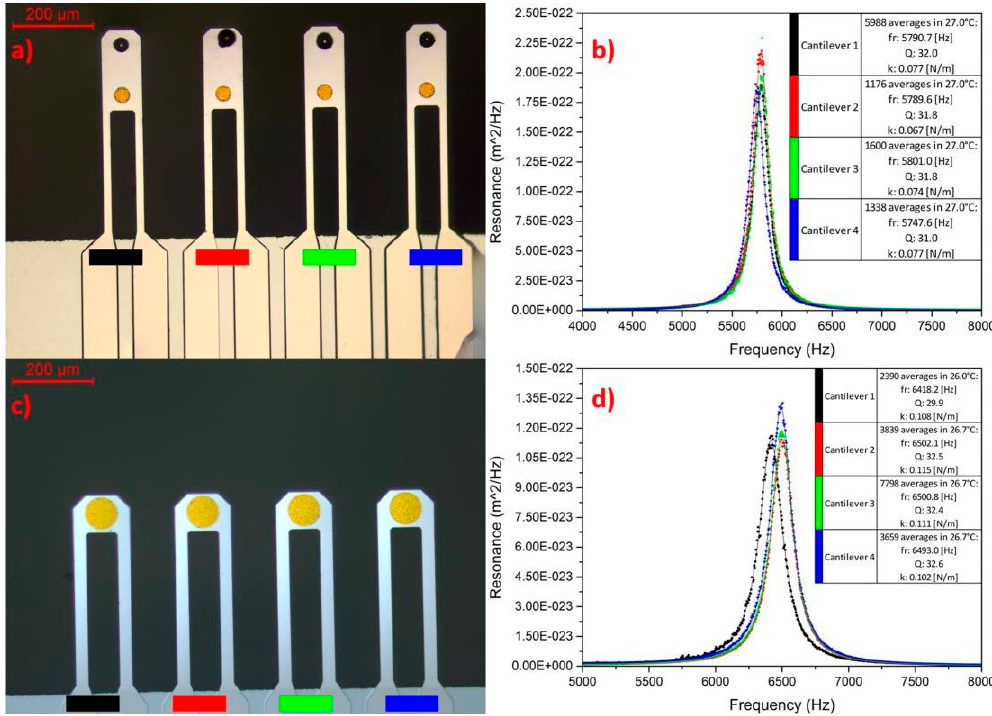
Figure 1. ( a ) Electromagnetically actuated array cantilevers with sphere mounted near their free end. Each cantilever integrates its own conductive loop, allowing for independent motion control; ( b ) thermomechanical noise measurements of the cantilevers (before sphere placement). The thermomechanical noise provides the estimated mechanical properties of each cantilever ( c ) Array with flat, gold functionalization layer. ( d ) Result of the thermomechanical noise measurements of the cantilevers with gold functionalization